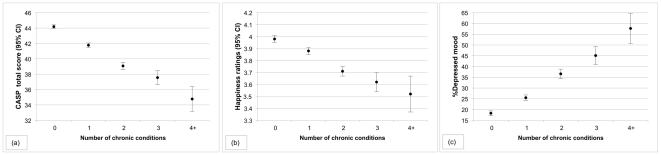
Co-morbidity and quality of life (a), happiness (b) and depressed mood (c).Panel (a) shows the mean quality of life scores (95% CI) for respondents with one, two, three and four or more conditions compared with those without a chronic condition, adjusted for age, gender and wealth. Higher scores indicate better QOL. Panel (b) shows the mean happiness ratings (95% CI) for respondents with no condition compared with one, two, three and four or more co-morbid chronic conditions, adjusted for age, gender and wealth. Higher scores indicate greater happiness. Panel (c) show the percentage of depressed mood, adjusted for age, gender and wealth, for respondents with one, two, three and four or more co-morbid conditions compared with those respondents with no chronic condition.